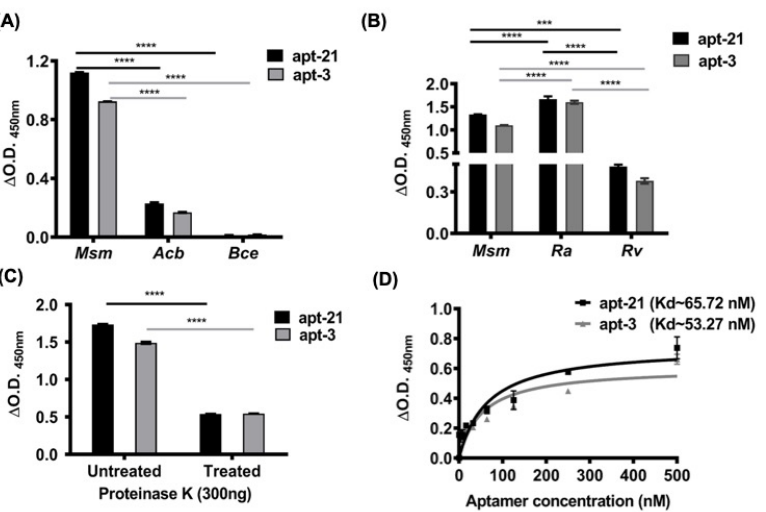
Figure 3. Aptamers-3 and -21 are specific to mycobacterial EVs and bind to surface proteins with very high affinity. ( A ) Equal protein equivalent of EVs from mycobacteria ( M. smegmatis ; Msm), Gram-negative ( A. baumannii ) and Gram-positive ( B. cereus ) bacteria ( X -axis) were screened for binding intensities (A 450nm ; Y -axis) to apt-3 (grey bars) and -21 (black bars). ( B ) Equal protein equivalent of EVs from non-pathogenic (Msm), attenuated (Ra), and virulent (Rv) (both Mtb) mycobacteria ( X -axis) were screened for binding intensities (A 450nm ; Y -axis) to apt-3 and -21. ( C ) Equal protein equivalent of Msm-derived EVs treated or untreated with proteinase K ( X -axis) were assessed for impact of proteinase K treatment on aptamer binding (A 450nm ; Y -axis) to apt-3 and -21. ( D ) Increasing concentrations (2–500 nM; X -axis) of apt-3 and -21 were bound to equal protein equivalent of Msm-specific EVs and screened for binding affinity (A 450nm ; Y -axis) to determine dissociation constant (Kd). Comparative statistical analyses were performed using ANOVA. *** p < 0.0006, **** p < 0.0001. ANOVA was performed on values obtained from replicates used in two independent experiments.